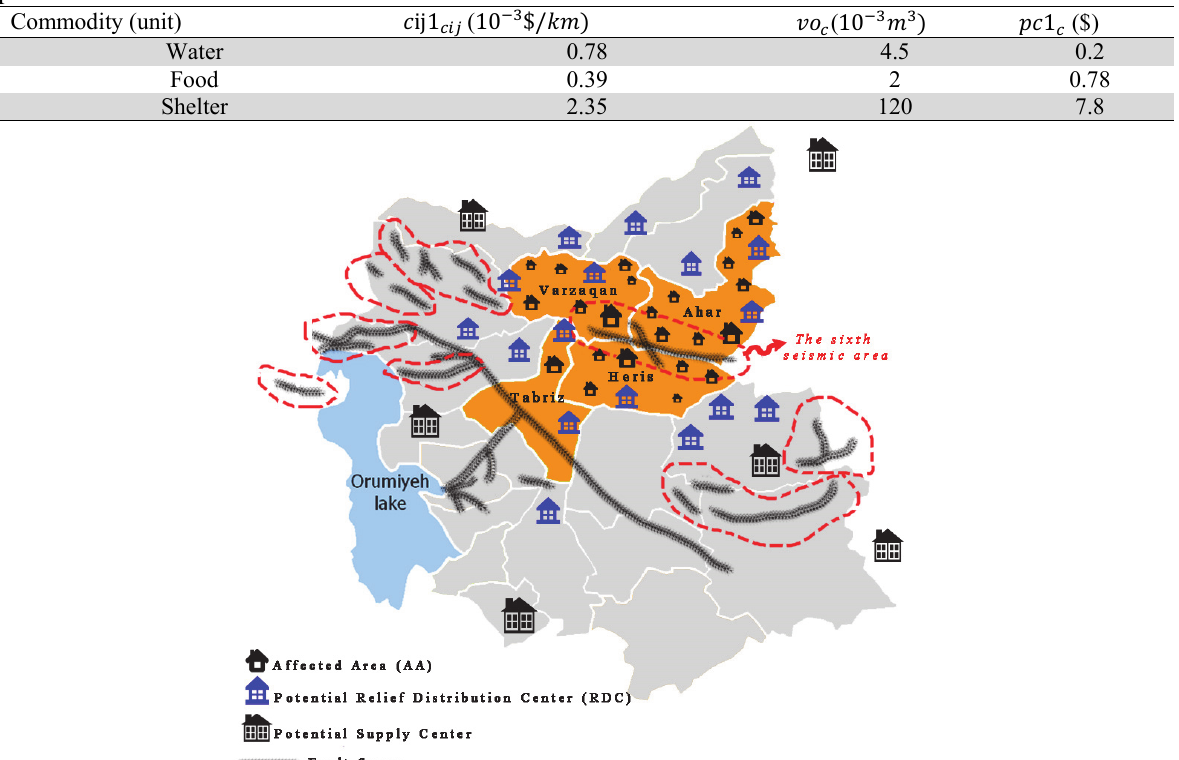
Procuring price, transportation cost and volume occupied by each commodity unit in preparedness phase